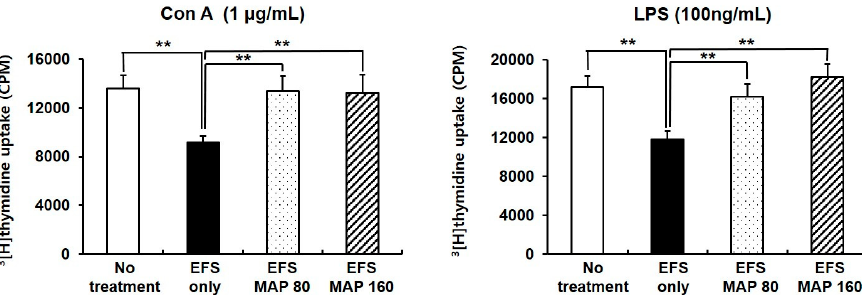
Figure 3. Protective effects of MAP on chronic EFS stress-induced suppression of lymphocyte proliferation. Mice are grouped as described in Figure 1. Isolated mice splenocytes were co-cultured with ( A ) Con A or ( B ) LPS. Proliferation of splenocytes was measured using 3 (H)-thymidine incorporation assay. Values are means ± SEM of three experiments, n = 7. ** p < 0.01 compared with control.